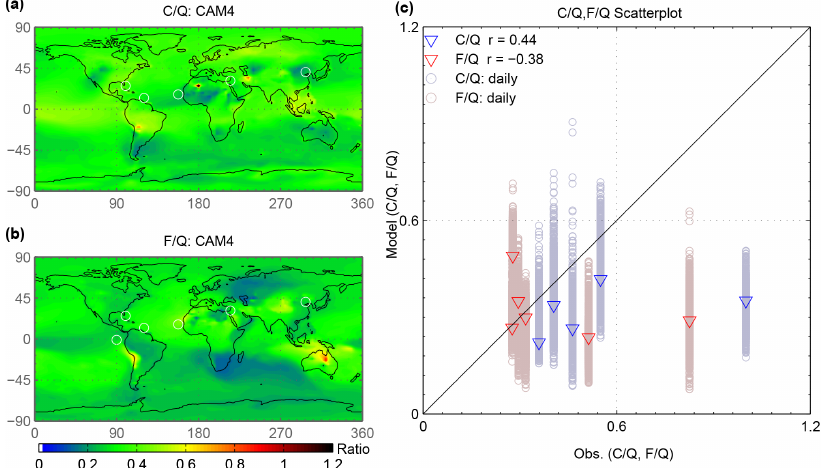
Figure 6. Calcite/quartz and feldspar / quartz mineral ratio comparison of mineral concentrations near the surface from CAM4 (e.g., kgC / kgQ) to bulk observational ratios from fieldwork by Glaccum and Prospero (1980), Prospero and Bonatti (1969), Kiefert et al. (1996), Falkovich et al. (2001) and Shi et al. (2005). Bright blue and red symbols in (c) represent averages for the month in which the observations occurred, while the pale red and blue symbols represent daily averaged values over the course of the simulations (2006–2011).